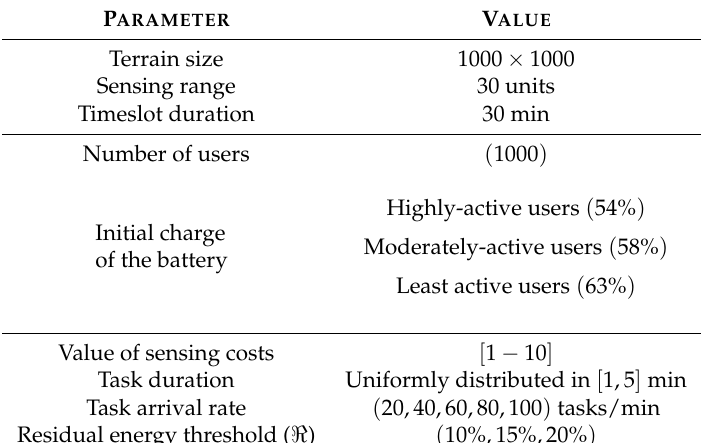
Table 4. Simulation